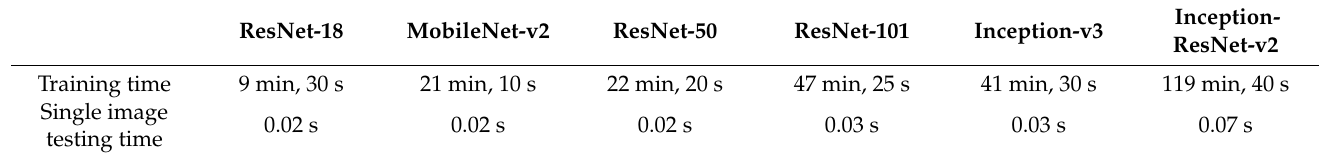
Table 5. Processing time details corresponding to different deep learning